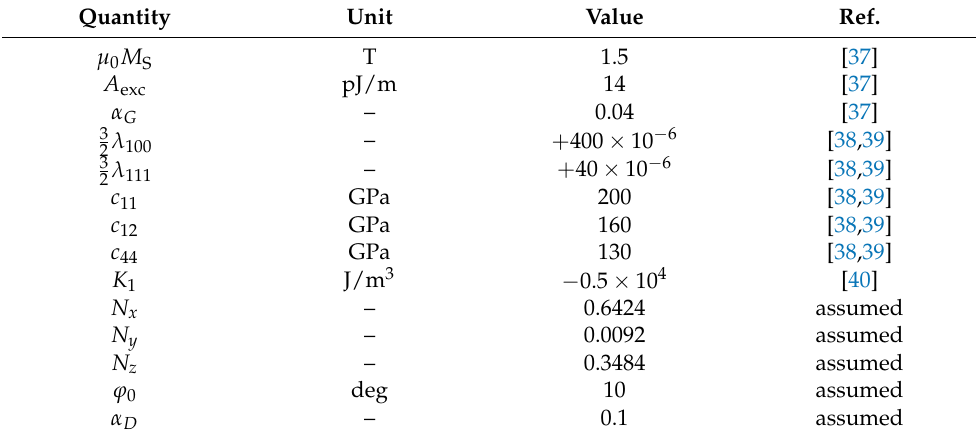
Table 1. Numerical values of parameters characterizing the Galfenol-based MS layer.